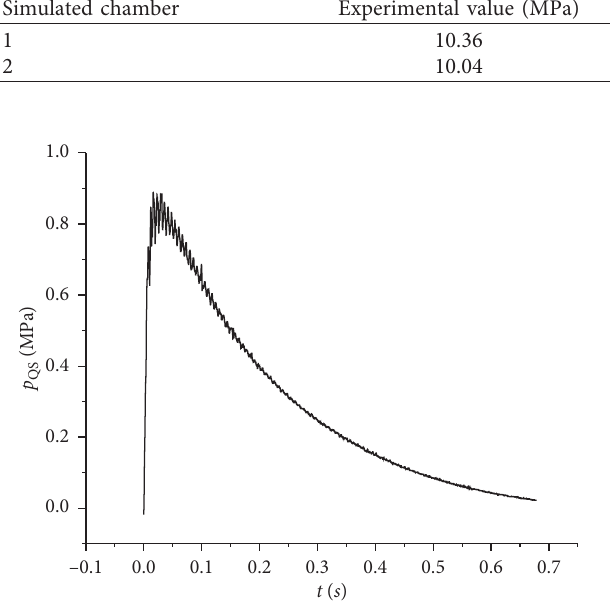
Figure 4: Quasistatic pressure p-t curve of simulated chamber 1.